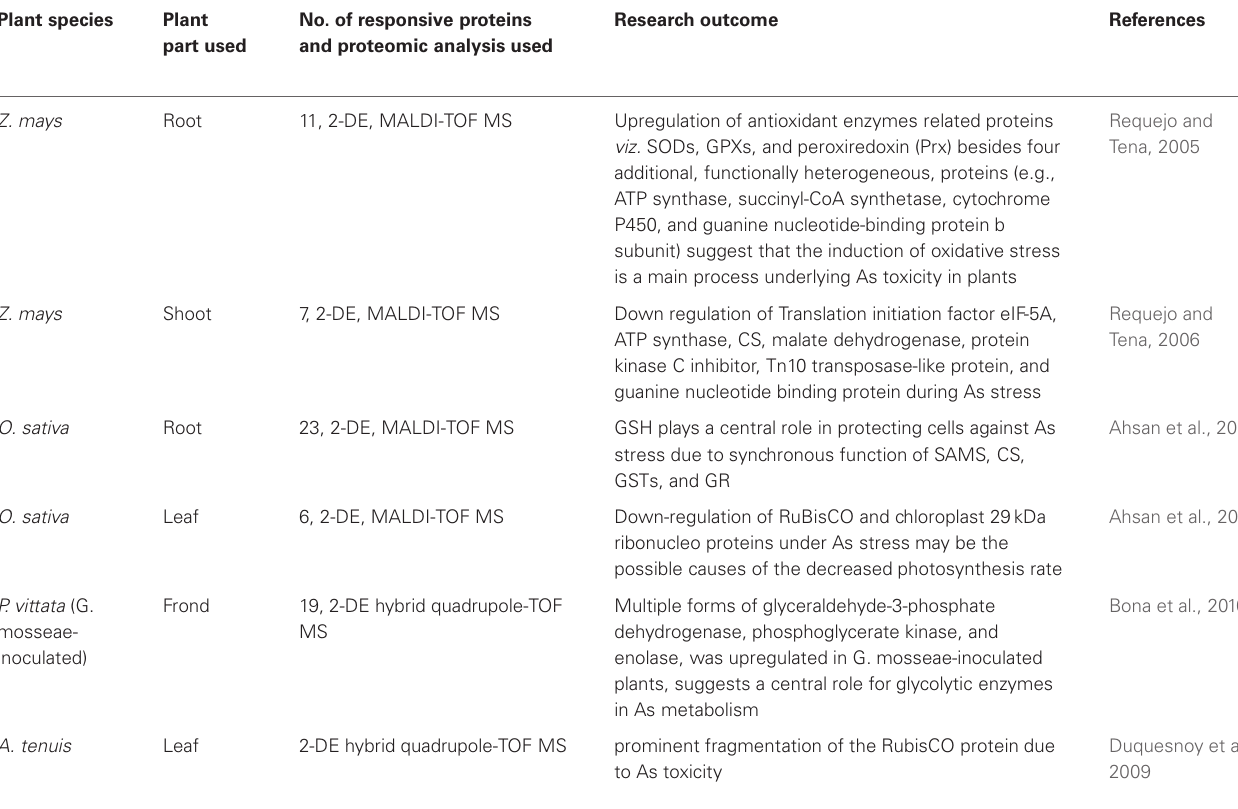
Table 2 | A review of “As” modulated proteins in different plant species during proteomic analysis. Plant